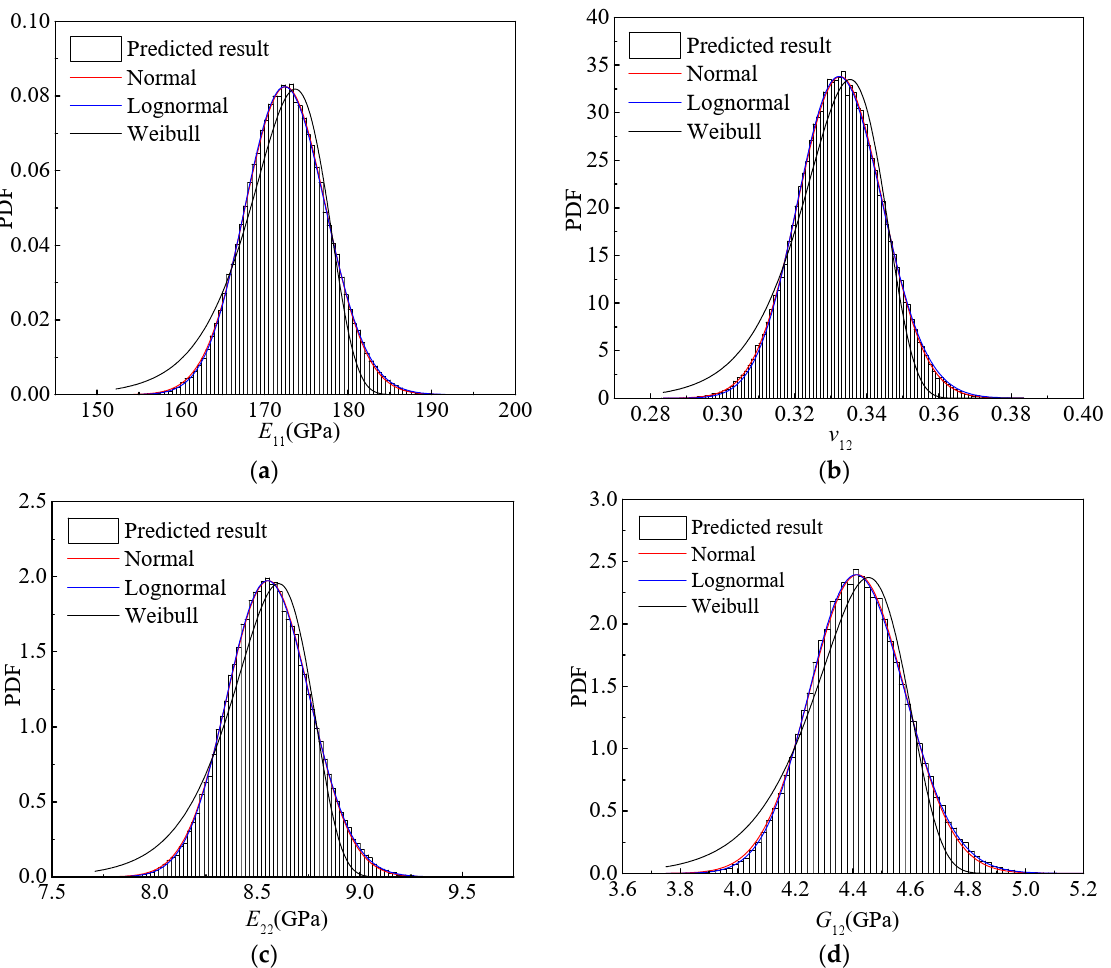
Figure 7. Histograms and PDFs of the elastic properties of the T800/X850 composite. ( a ) E 11 ; ( b ) v 12 ; ( c ) E 22 ; ( d ) G 12 .